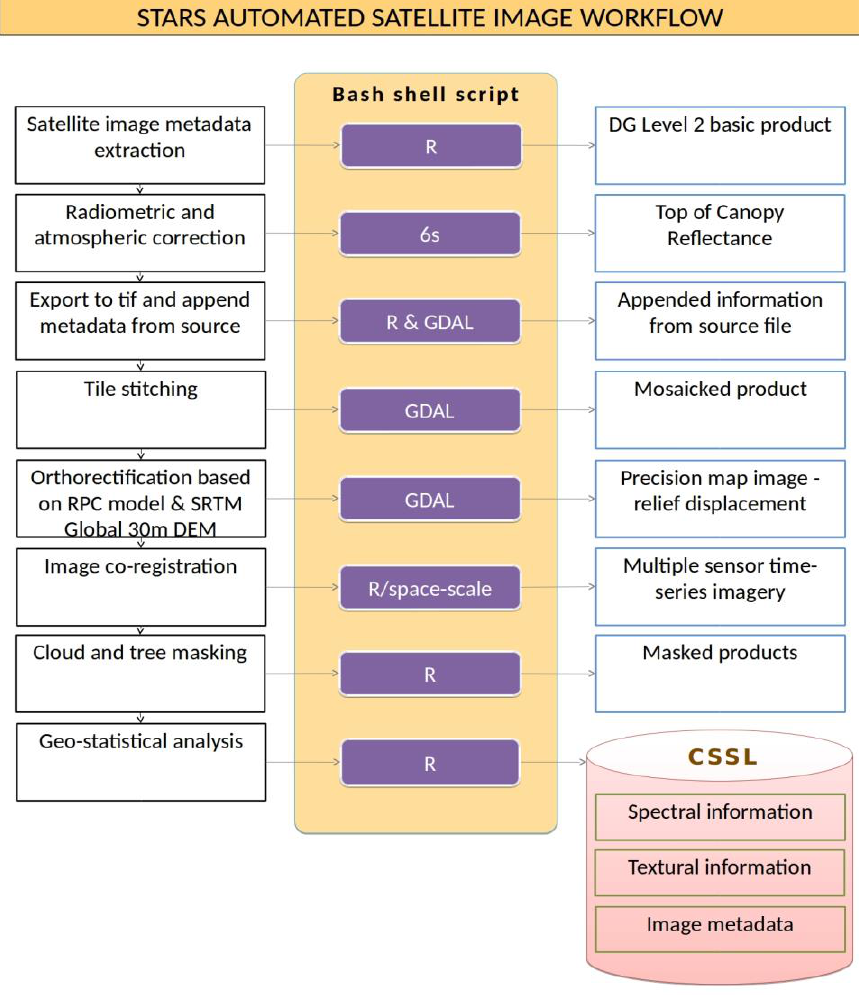
Figure 3. The processing chain of the STARS automated satellite image workflow.